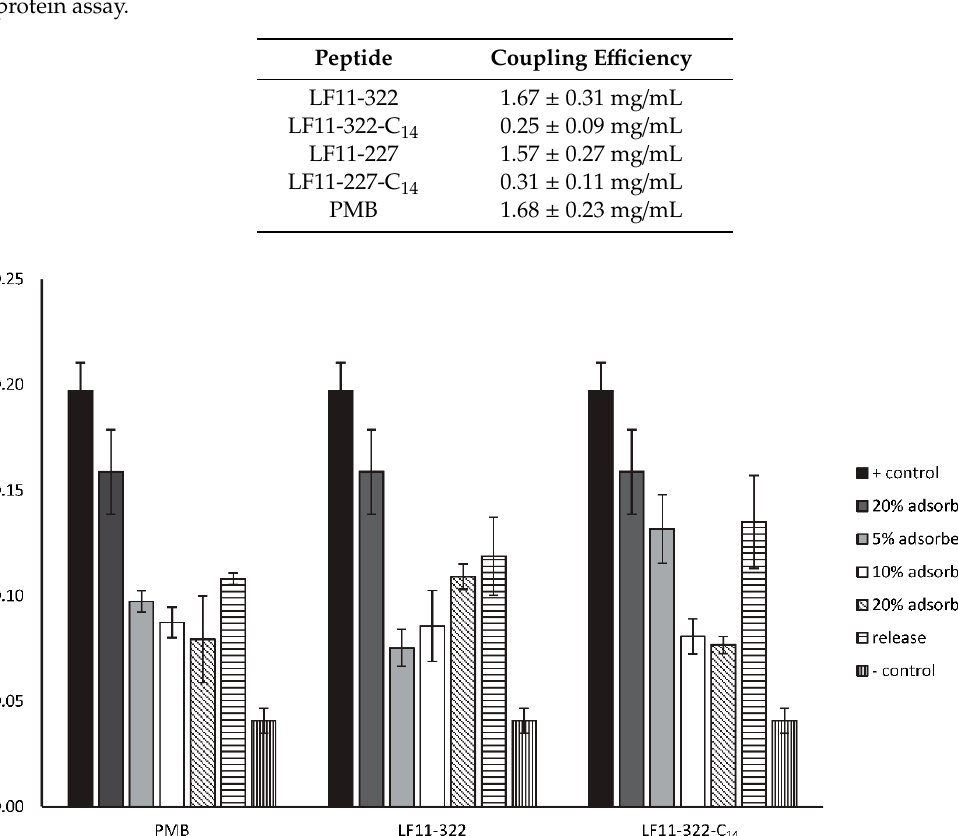
Figure 10. Antimicrobial properties of peptides immobilized on NHS-activated agarose beads against E. coli . 5, 10 and 20% ( v / v ) of immobilized adsorbent was incubated with E. coli suspension overnight. Bacterial growth was determined by turbidity measurement (OD 620 nm). Bacteria suspension without adsorbent was used as a positive control ( + control). Müller-Hinton broth without bacteria was used as the negative control. Additionally, a bacteria suspension was incubated with adsorbent without immobilized peptides (adsorbent-AMP). To check if the antimicrobial properties caused by a peptide release form the adsorbent, supernatants from 20% adsorbent suspensions were included in the test (release) ( n = 3).